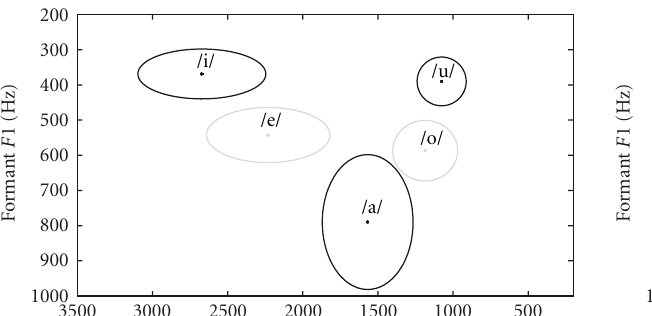
Table 6: Mean ( μ ), standard desviation ( σ ), skewness ( γ corpus.